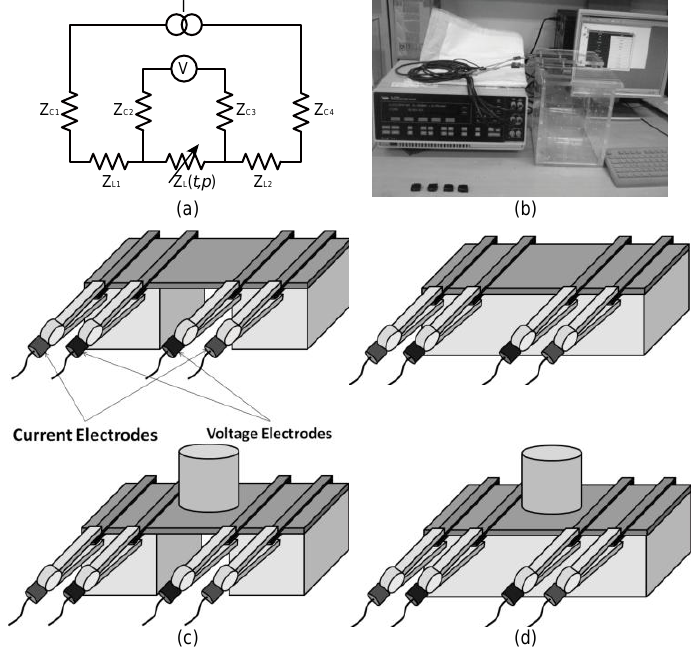
Figure 3. EIS measurements of conductive fabrics under tension and compression. ( a ) Four-electrode method for impedance measurements. ( b ) Measurement setup using the Solartron 1260 impedance analyzer. ( c ) EIS measurement setup for applied tension using acrylic supports. ( d ) EIS measurement setup for applied